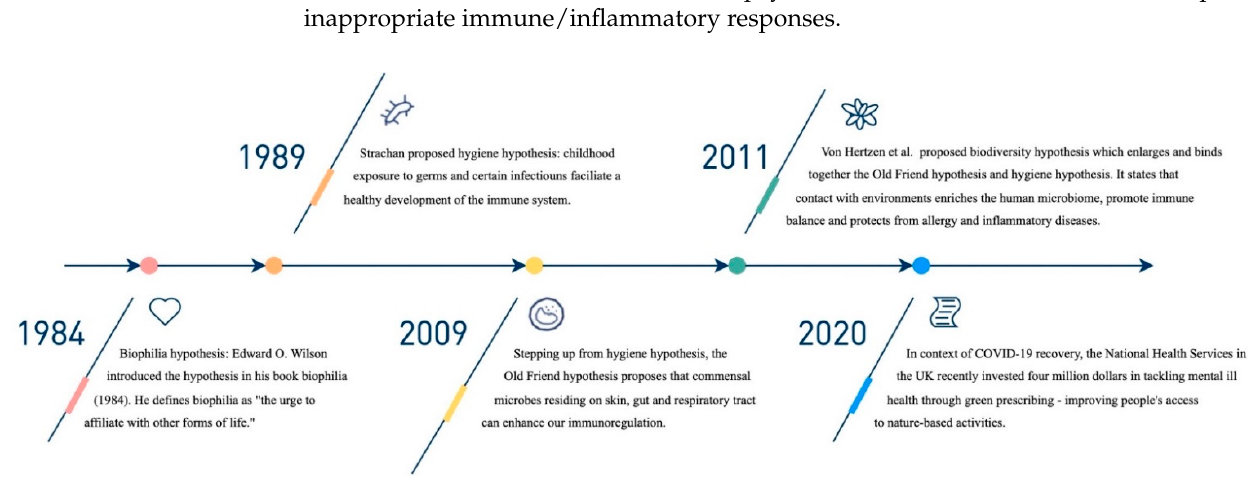
Figure 1. Key events important to the biodiversity hypothesis.